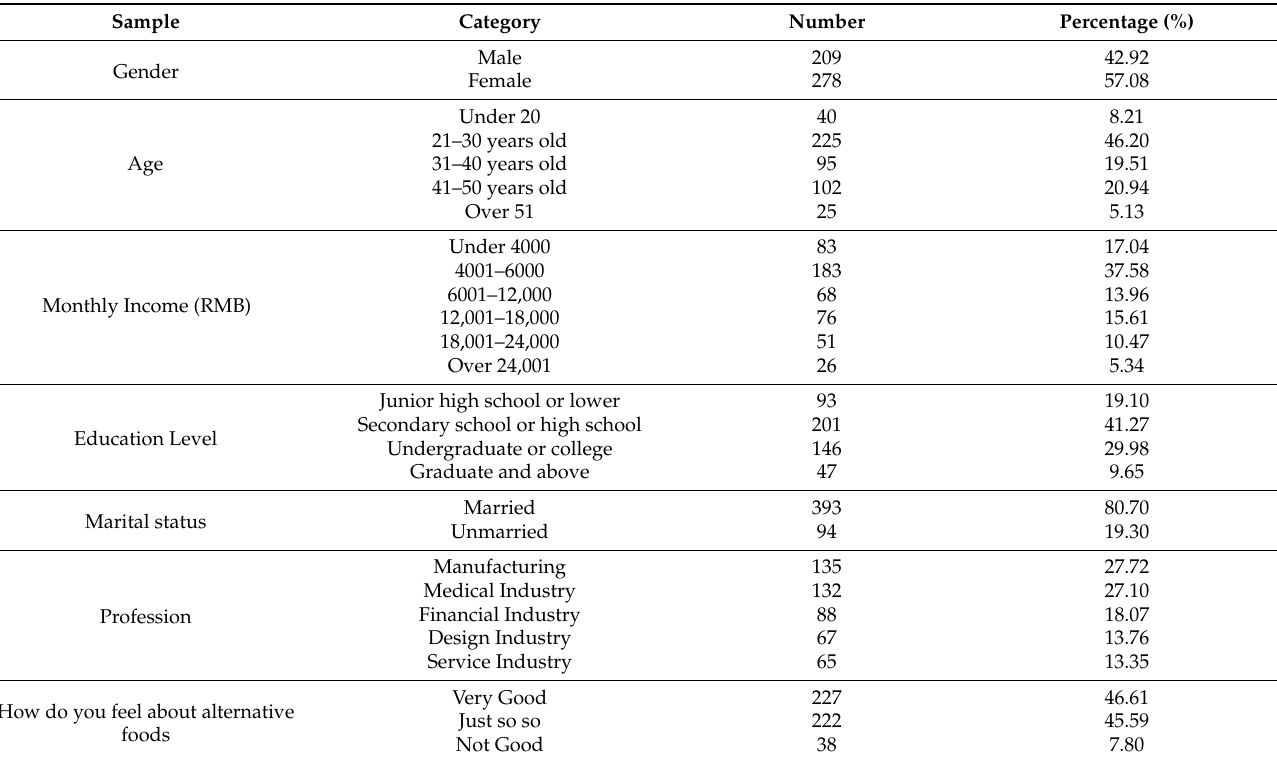
Table 2. The basic information of the respondents.